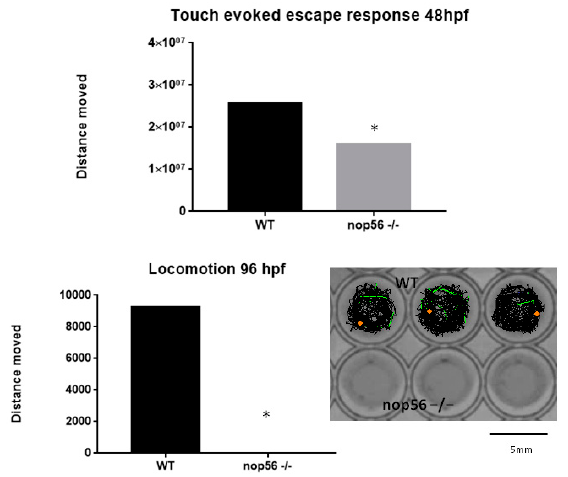
Figure 10. Touch-evoked escape was reduced at 48 hpf in nop56 − / − embryos and locomotion was absent in nop56 − / − larvae at 96 hpf ( p -value < 0.0001). Statistically significant data in the graphs are indicated with a *.